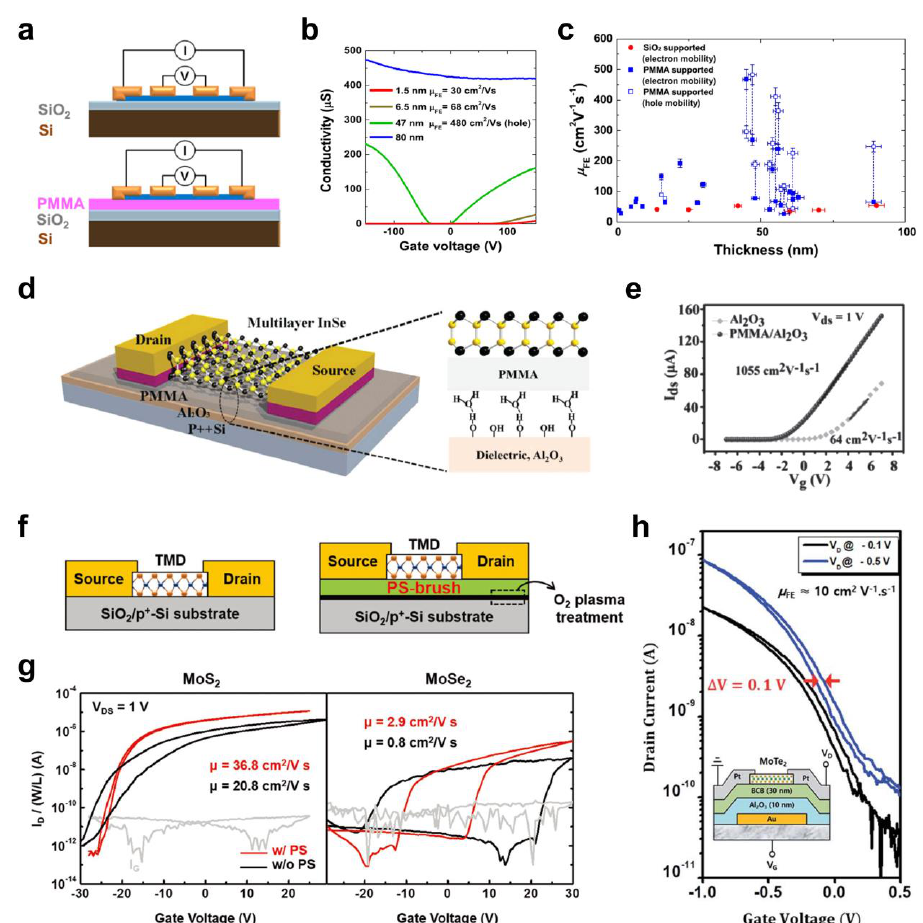
Figure 1. ( a ) Schematic illustration of four − probe measurement of 2D MoS 2 − based devices. ( b ) Conductivity of 2D MoS 2 on PMMA with respect to V G . ( c ) Mobility values in relation to the thickness of the 2D MoS 2 on PMMA compared to those for SiO 2 [59]. Copyright © 2013, AIP Publishing. ( d ) Schematic diagram of 2D InSe FET using a PMMA/Al 2 O 3 bilayer dielectric and ( e ) the I D − V G characteristics compared to those without PMMA [60]. Copyright © 2013, John Wiley and Sons. ( f ) Schematic drawing of 2D TMD (MoS 2 and MoSe 2 ) FETs with SiO 2 dielectric (left) showing PS brush interfacial layer (right) and ( g ) their transfer characteristics [61]. Copyright © 2018, John Wiley and Sons. ( h ) Transfer curves for 2D MoTe 2 FET based on BCB/Al 2 O 3 bilayer dielectric with different drain voltages ( V D ) (inset: cross − sectional device structure) [62]. Copyright ©